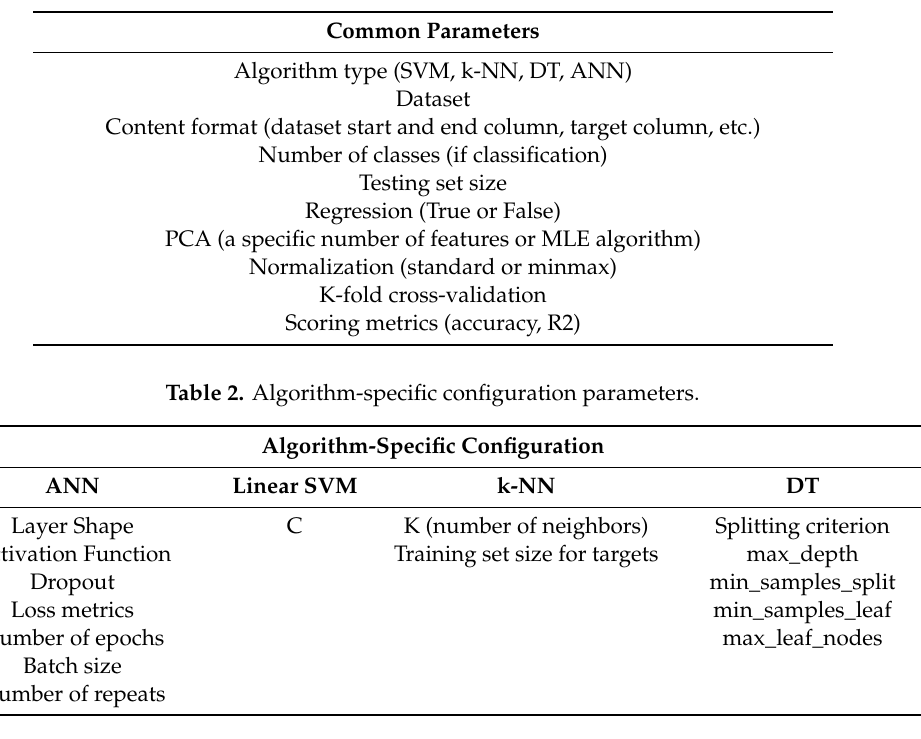
Table 1. Common configuration parameters.